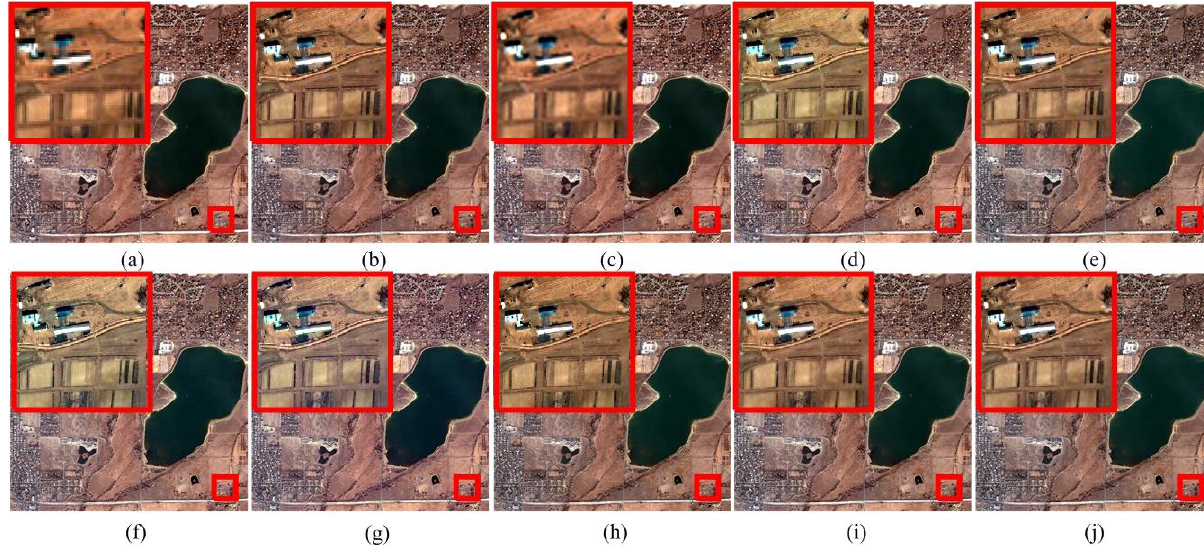
Figure 3. The pansharpening result of Boulder dataset. (a) original MS image, (b) proposed PSBP method (c) EXP method (d) GS